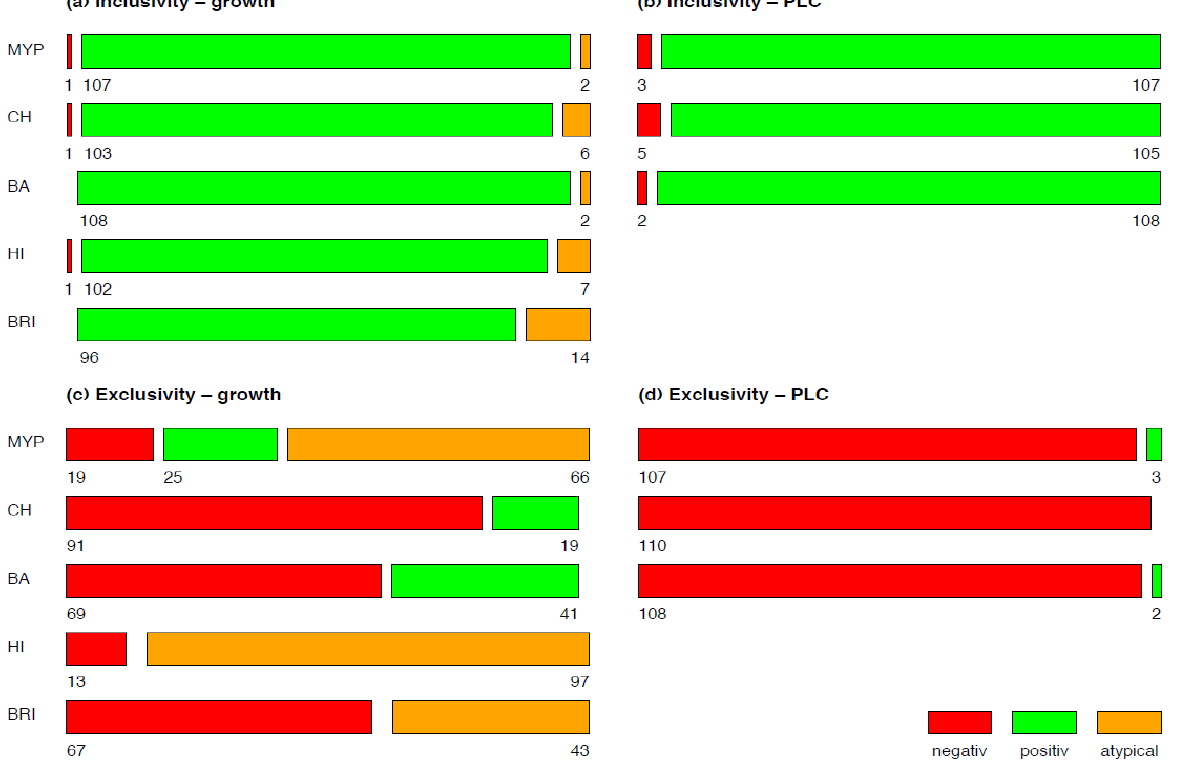
Figure 2. Typical ( A – E ) and atypical colonies ( F – J ) of Bacillus cereus sensu lato on MYP agar (A (BCG 6), F (BC 66)), ChromoSelect Bacillus agar (B (BC 30), G (BC 20)), Brilliance™ B. cereus agar (C (BC 2), H (BC 19)), CHROMagar™ B. cereus (D (BC 63), I (BC 2)) and BACARA ® agar (E (BC 50), J (BC 34)). Bluish-green colonies are the result of β -D-glucosidase reaction. Precipitation zones surrounding typical colonies are caused by phospholipase C reaction, while lack of mannitol fermentation results in pink background. Abbreviations: MYP—mannitol egg yolk polymyxin agar; HI—ChromoSelect Bacillus agar; BRI—Brilliance™ B. cereus agar; CH—CHROMagar™ Bacillus cereus ; BA—BACARA ® agar.